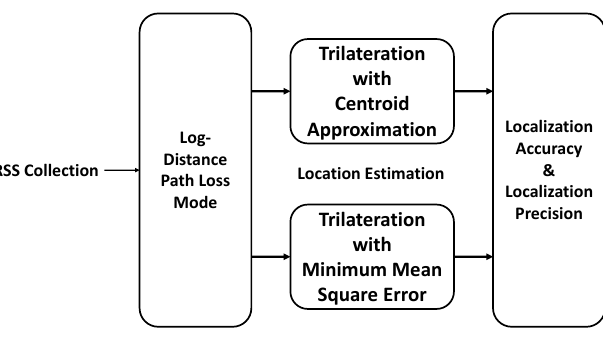
Figure 3. Trilateration Based Localization